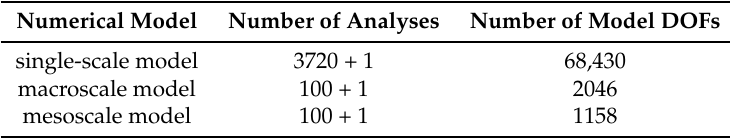
Table 4. Stiffened fuselage section problem: approach-dependent number of analyses and relevant computational burden at constant resolution length (cid:96) .